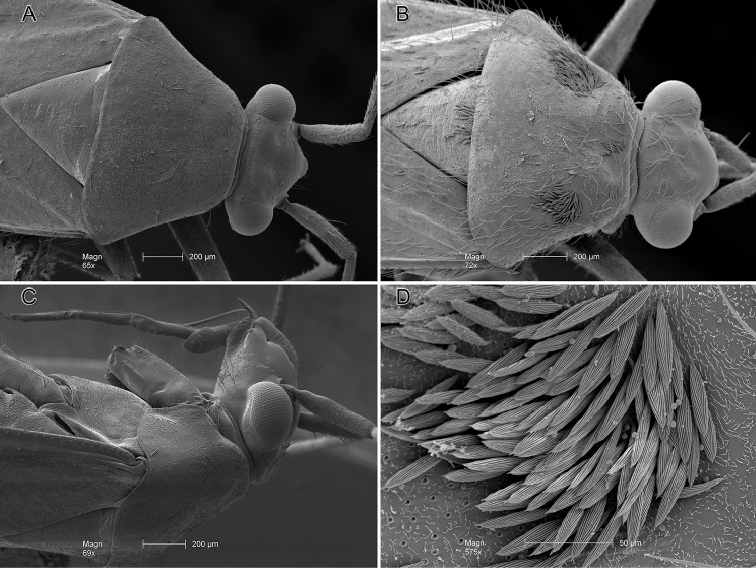
Scanning electron micrographs. AIlnacorahenryi, head and pronotum, dorsal view BIlnacorainusta, head and pronotum, dorsal view CIlnacorahenryi, head and pronotum, lateral view DIlnacorainusta, detail of pronotal scale-like setae, dorsal view.